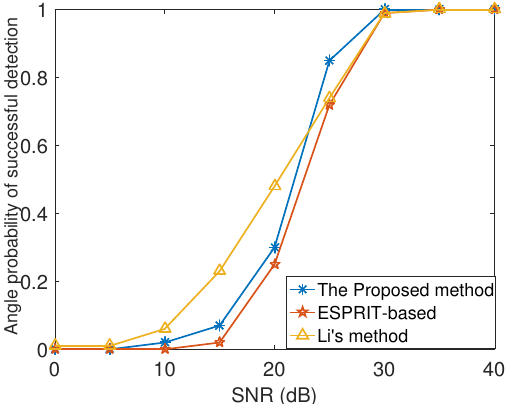
Figure 10. Probability of successful detection of angle estimation versus SNR, L = 200. The proposed algorithm also has significant advantages in gain-phase error estimation, which can be verified by following numerical experiments. In this experiment, the number of snapshots L = 200. According to Figure 12, we can see that the PSD of both methods augments with the rise of SNR, and eventually reaches 100%. In addition, the PSD of the proposed method can achieve 100% faster and the SNR threshold is lower. The reason error accumulation effect in the gain-phase error estimation, so it can obtain more accurate gain-phase error estimation.